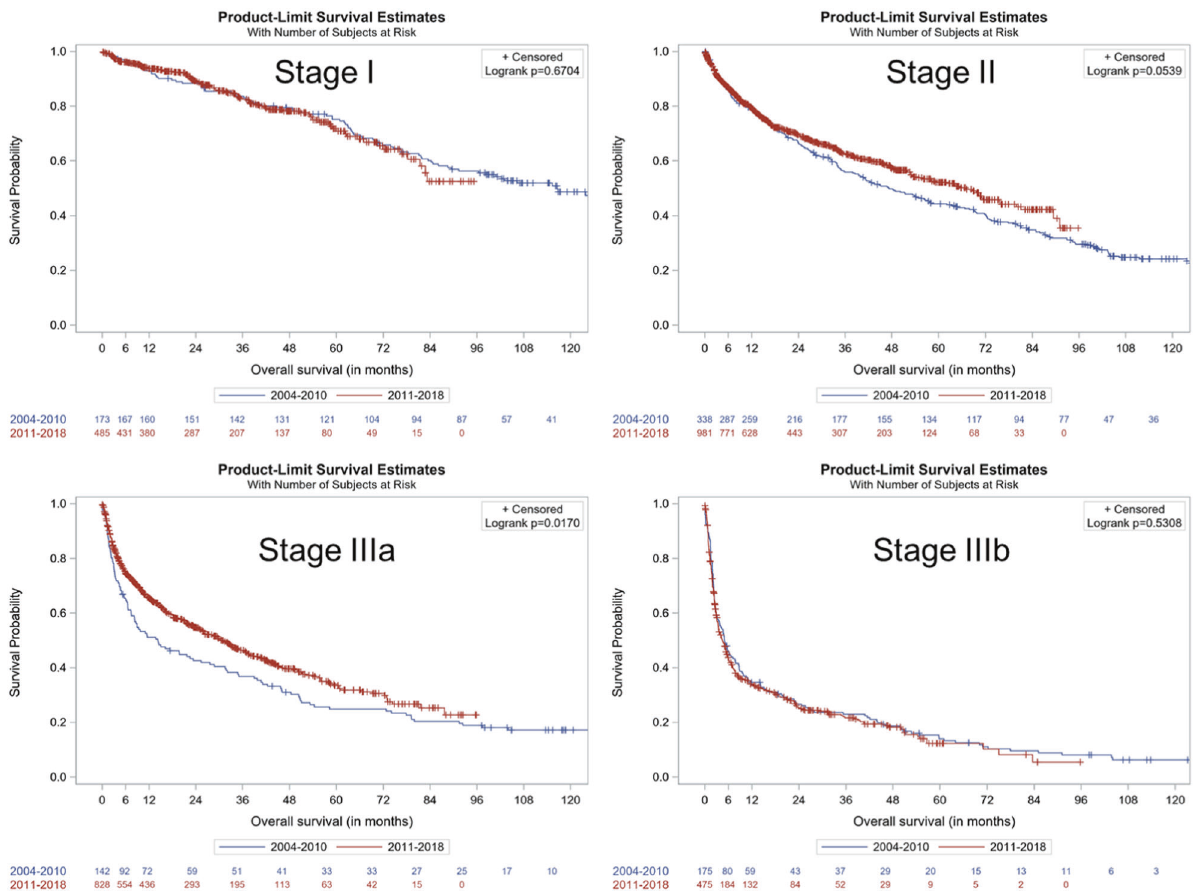
Fig. 1 Kaplan – Meier graph of overall survival by fi rst-line treatment initiation period (pre- and post-2010) and Mayo2004/European stage at diagnosis. Stage I, Stage II, Stage IIIa and Stage IIIb represent the comparison of survival curves in the pre- and post-2010, separately for the respective patient subgroups de fi ned by Mayo 2004/European stage at diagnosis.